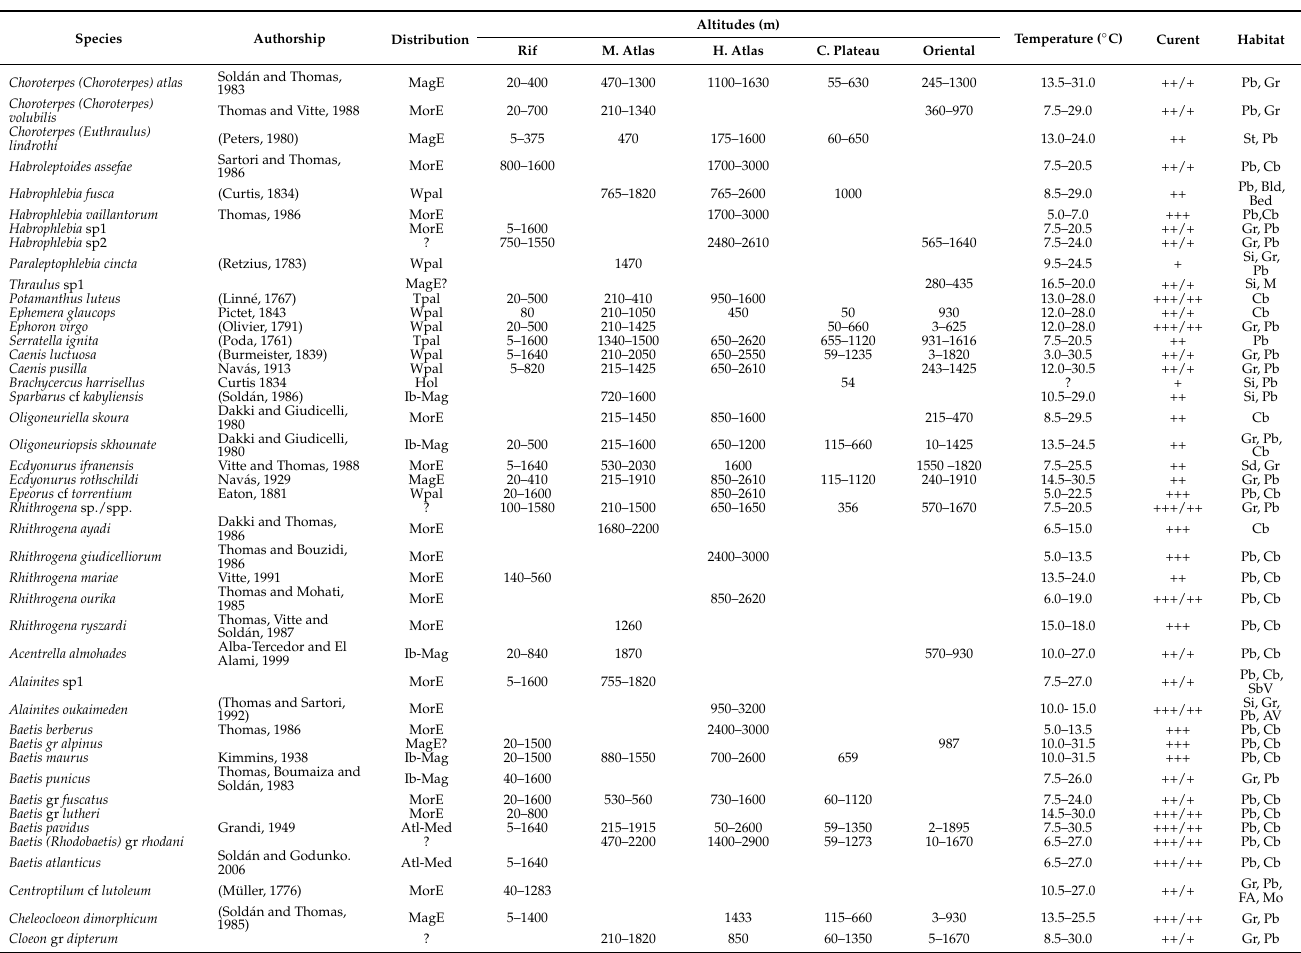
Table 1. Checklist of the Moroccan Ephemeroptera, with their geographical distribution and habitat